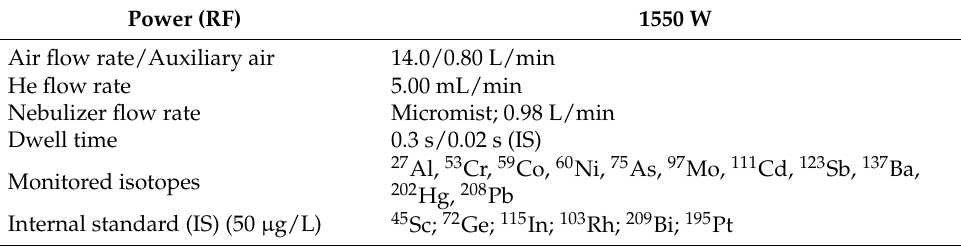
Table 1. ICP-MS parameters used for the determination of inorganic contaminants in yogurt samples.